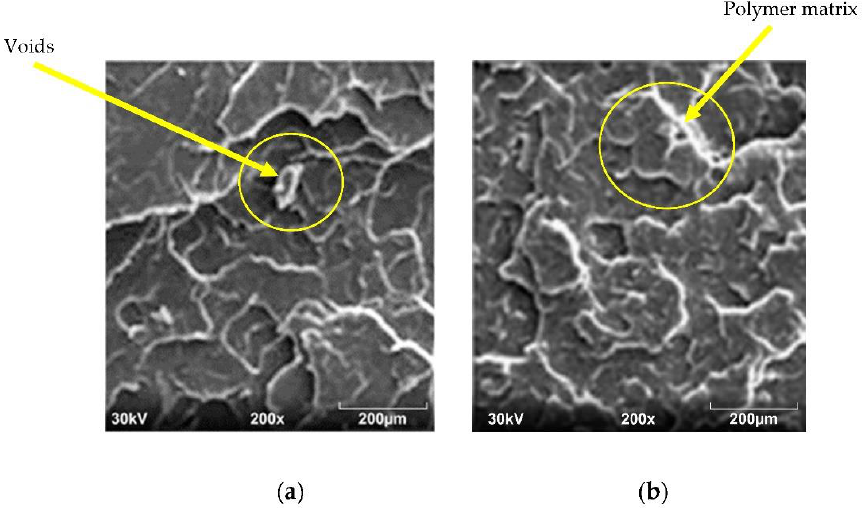
Figure 7. SEM images of the tensile fracture surfaces of the epoxy matrix specimens (200×): ( a ) CP1 and ( b ) CP2.